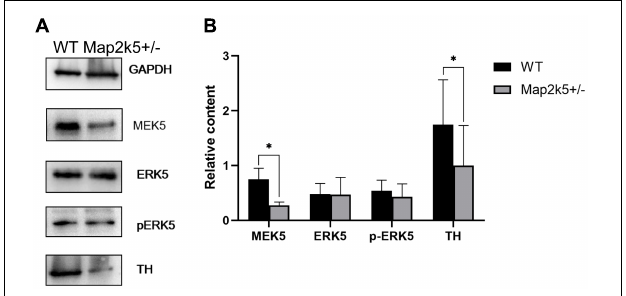
FIGURE 5 | (A) Representative Western blots images of MAP2K5, ERK5, phosphorylated ERK5 (active), TH protein, and GAPDH are depicted. (B) Data from male WT and Map2k5 + / − mutant mice were pooled for this analysis. Bar graph is hemi-quantitative analysis of the Western blot, showing a significant decrease in MAP2K5 and TH (P Map2k5 = 0.023, P TH = 0.013, respectively) in the Map2k5 + / − mutant mice. Results are plotted as mean with SEM (paired t -test, n = 4). Results are plotted as mean with SEM. Bars represent means with SEM. * P < 0.05.